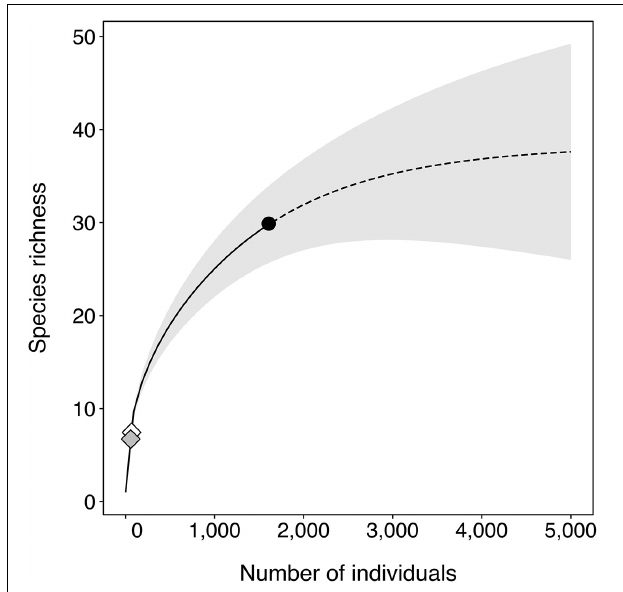
FIGURE 3 | Individual-based rarefaction (solid line) and extrapolation (dashed line) of species richness ( S ) from mid-water BRUVS samples, with 95% unconditional confidence interval (shaded area). The reference value (i.e., observed species richness) is shown as a filled black circle. Diamonds mark the estimated value of S corresponding to samples of 40 (gray) and 50 (white) individuals, for comparison with previous studies (see section “Species